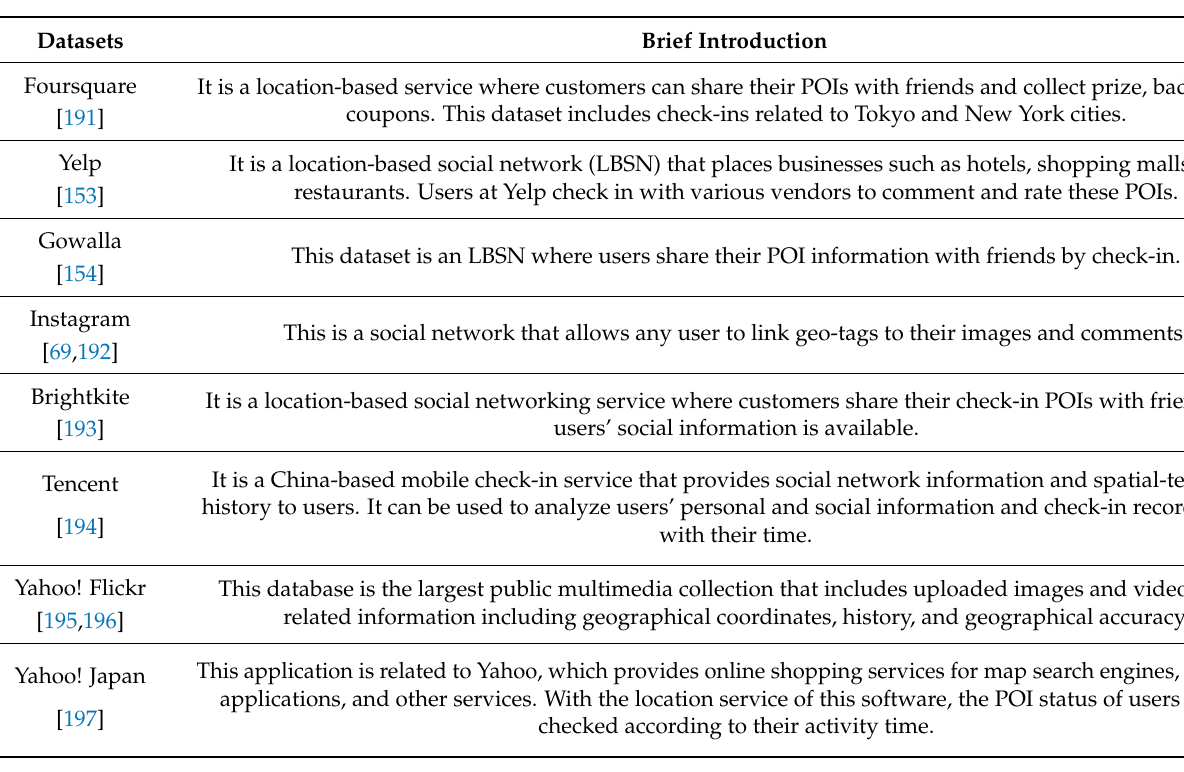
Table 3. A brief description of the most popular datasets employed in selected